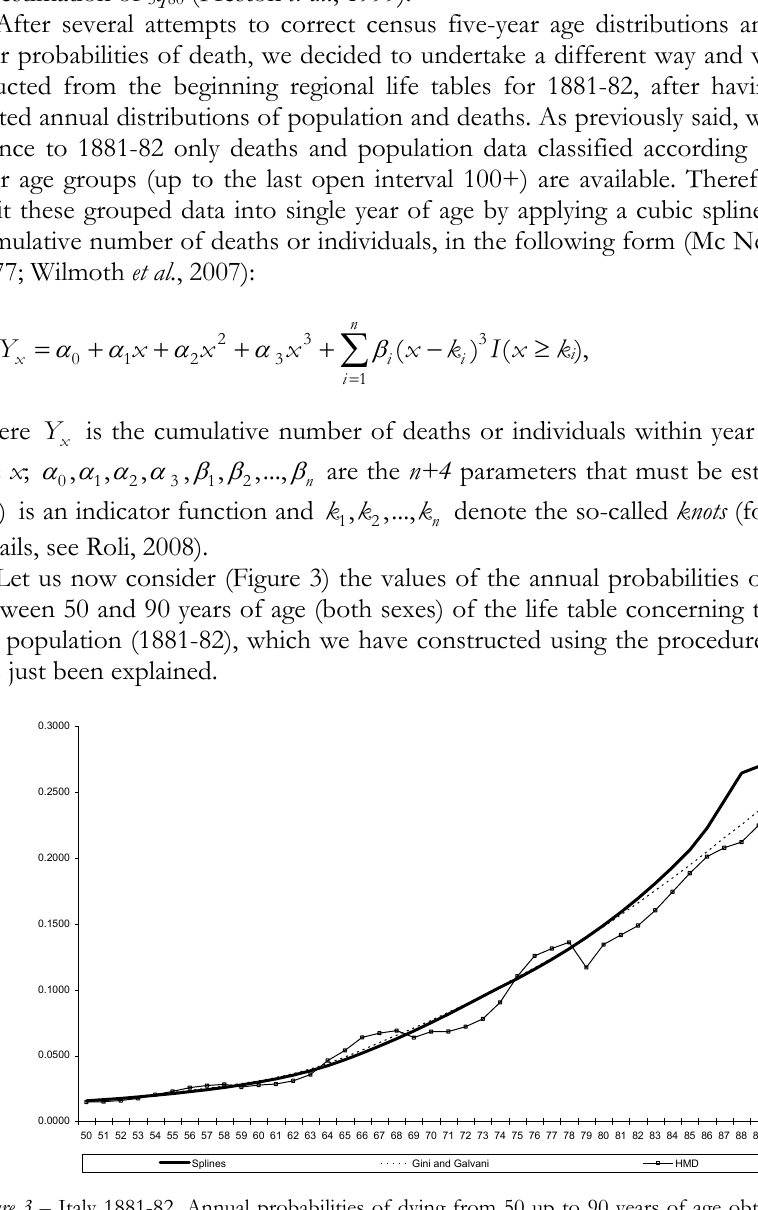
Figure 3 – Italy 1881-82. Annual probabilities of dying from 50 up to 90 years of age obtained by: spline smoothing, Gini and Galvani’s tables and HMD